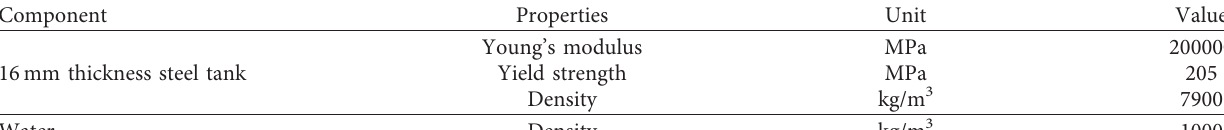
Table 1: Mechanical properties of steel storage